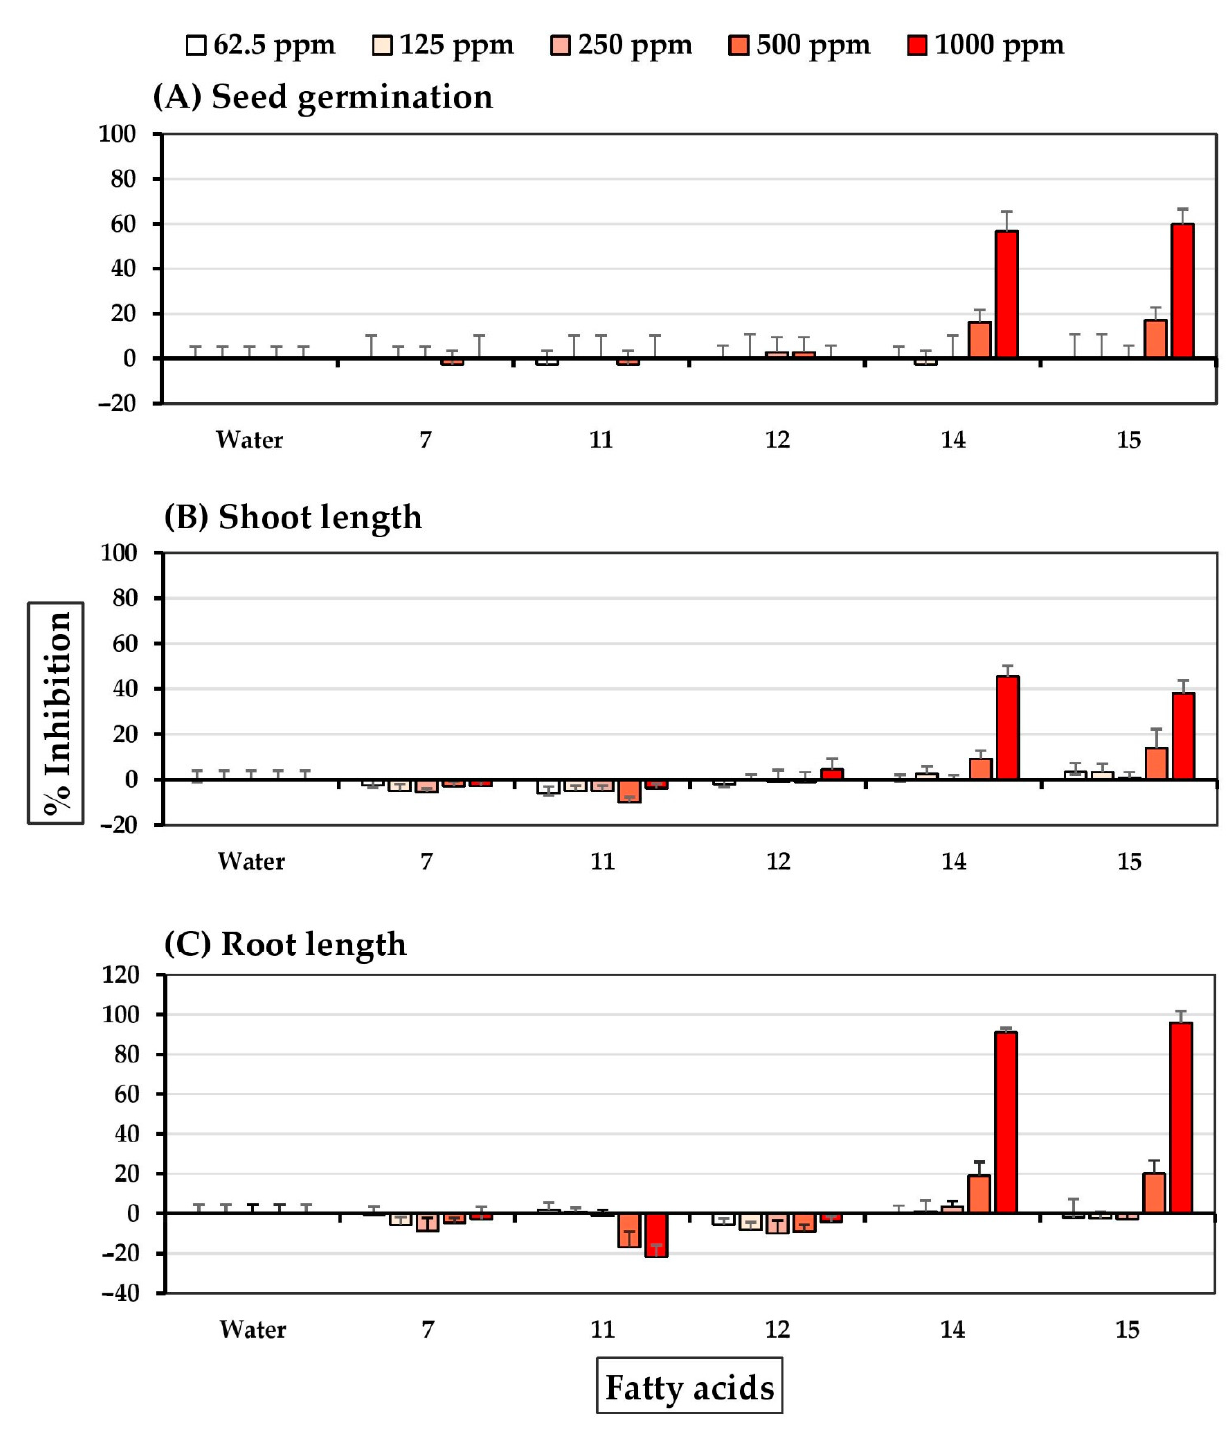
Figure 8. Inhibitory effects of fatty acids of S. platensis on ( A ) seed germination, ( B ) shoot length, and ( C ) root length of barnyardgrass. Distilled water was used as a